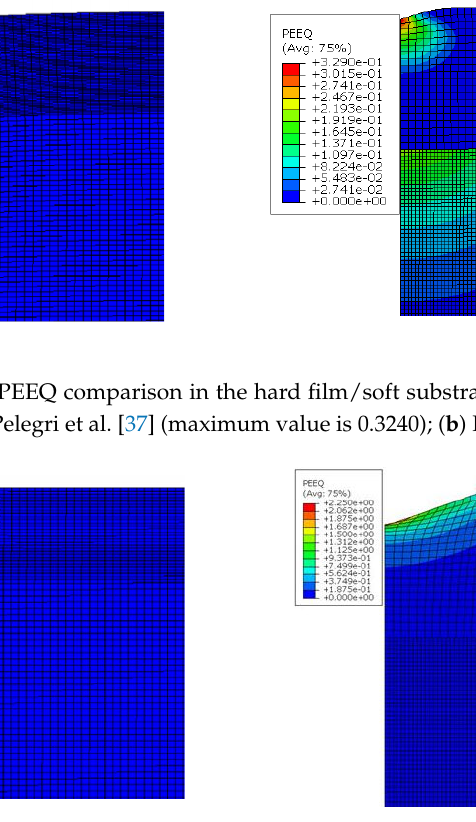
Figure 8. PEEQ comparison in soft film/hard substrate model at h max = 900 nm: ( a ) reported result by Pelegri et al. [37] (maximum value is 2.419); ( b ) FE result (maximum value is 2.250).